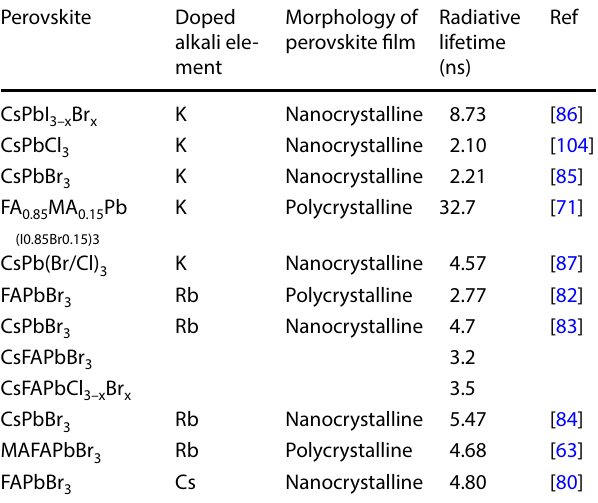
Table 3 Radiative lifetime analysis for the alkali doped halide per- ovskite materials Morphology of Radiative Perovskite Doped perovskite film alkali ele- ment